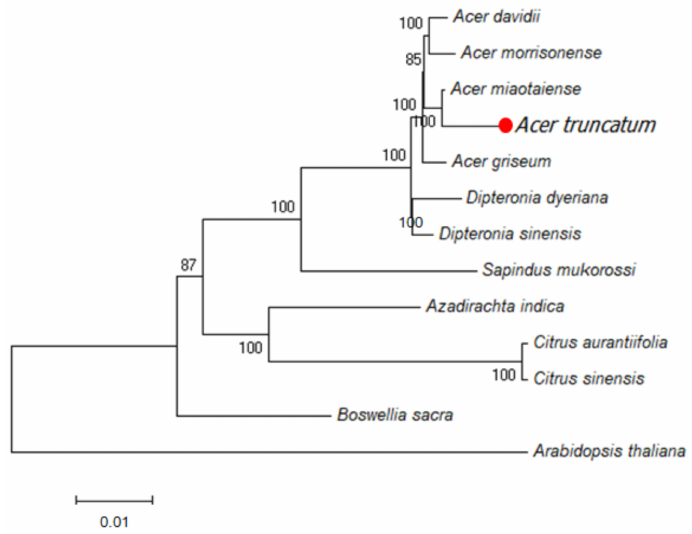
Figure 6. Maximum likelihood (ML) phylogenetic tree inferred from 13 chloroplast genomes.